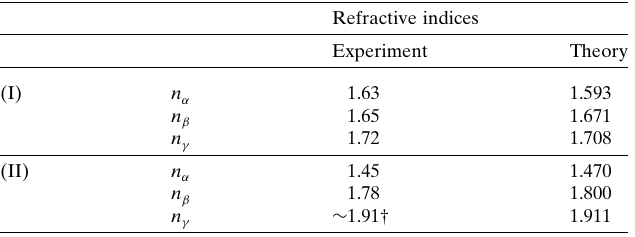
Table 1 Experimental refractive indices (589 nm) and results of Q-LFT/MP2/6- 311++G(d,p)